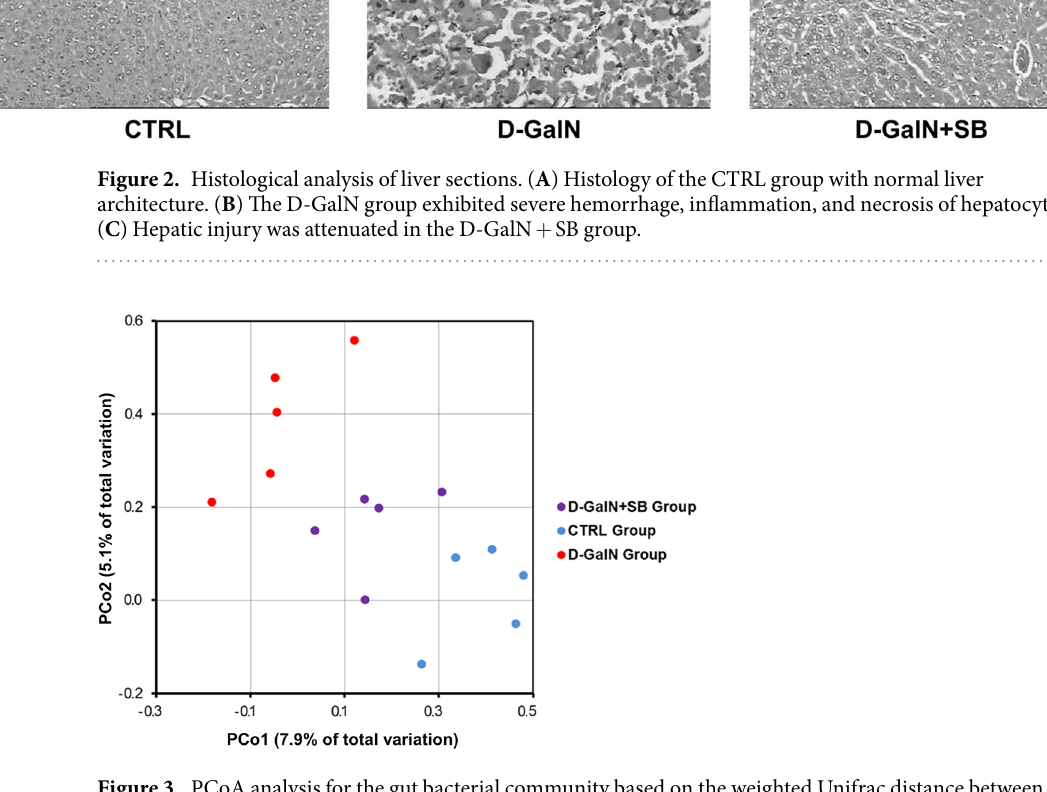
Figure 3. PCoA analysis for the gut bacterial community based on the weighted Unifrac distance between the CTRL group (blue dots), the D-GalN group (red dots) and the D-GalN + SB group (purple